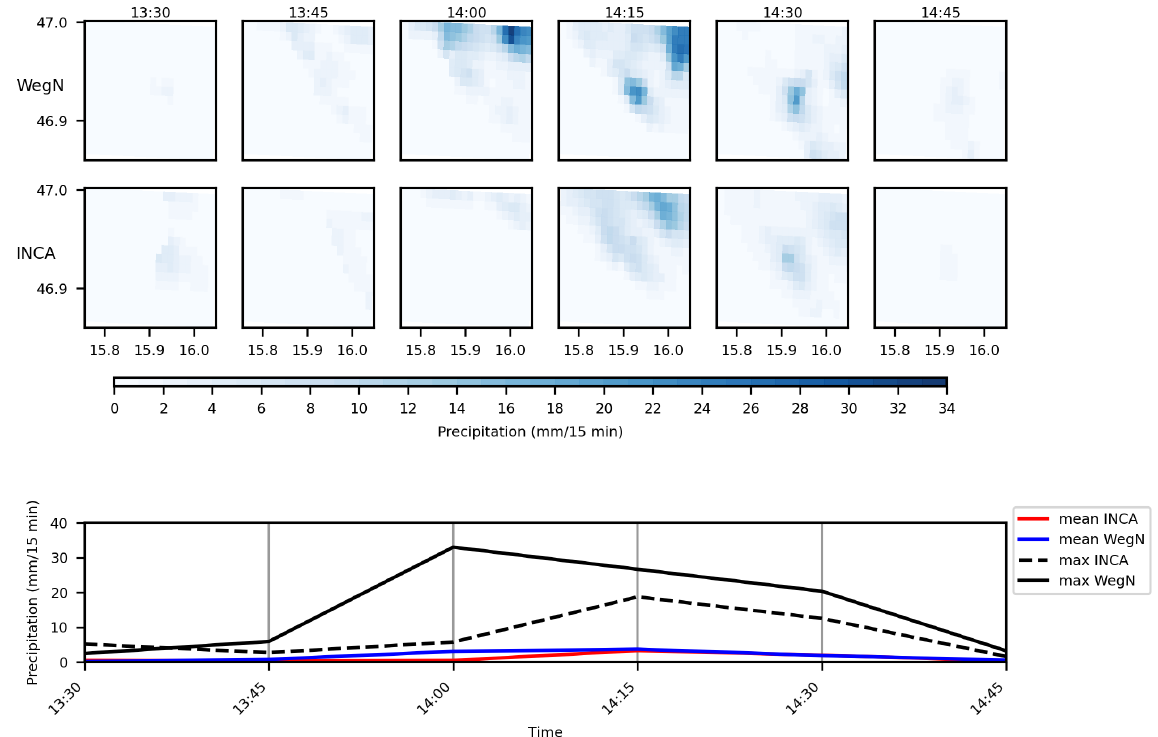
Figure 14. An event on 15 July 2018 in WegenerNet (top) and INCA (center) and time series of maximum and areal mean values in INCA and WegenerNet